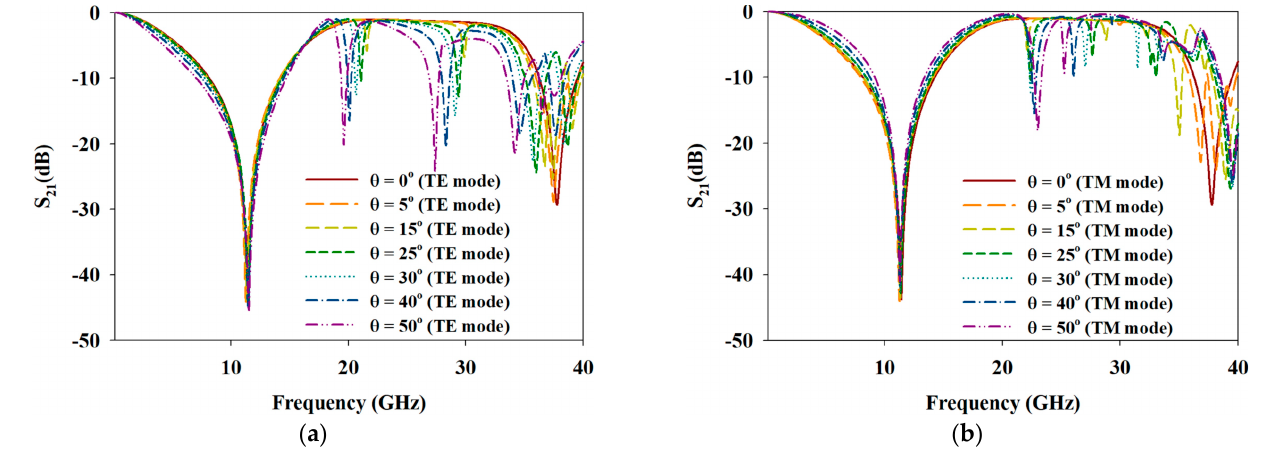
Figure 12. Simulated responses of transparent MFSS under the influence of oblique angle variations of ( a ) TE mode and ( b ) TM mode incidents.